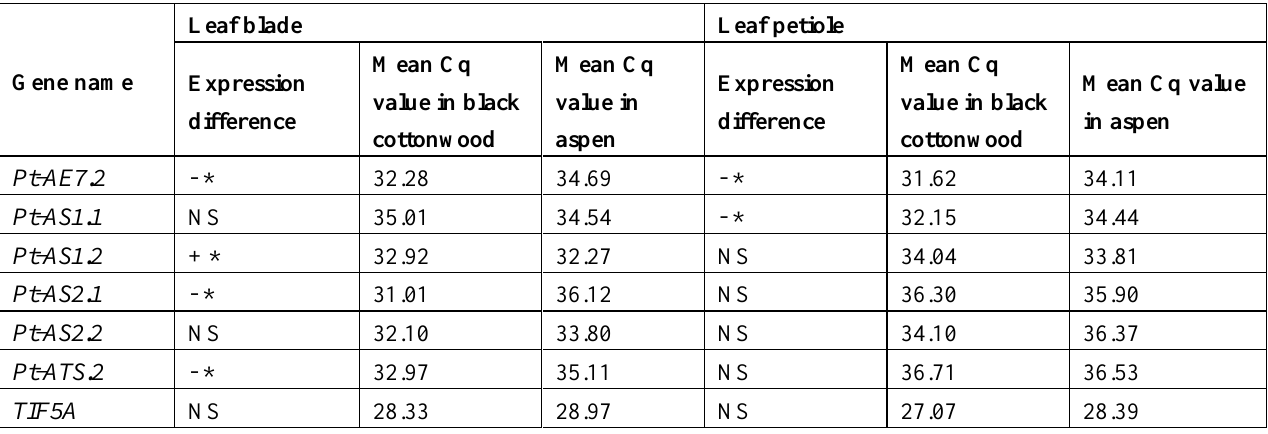
Table S3. Mean Cq values (from qRT-PCR) used to calculate relative expression (aspen relative to black cottonwood) in leaf blades and petioles, graphed in Figure 3 and TIF5A